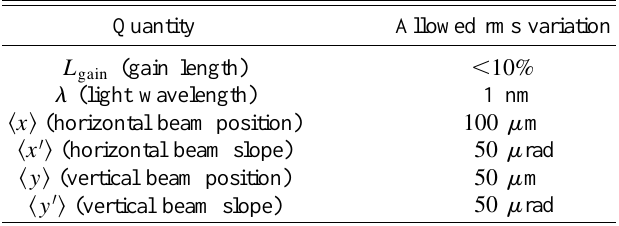
TABLE III. Performance specifications for free-electron laser (FEL) operation.